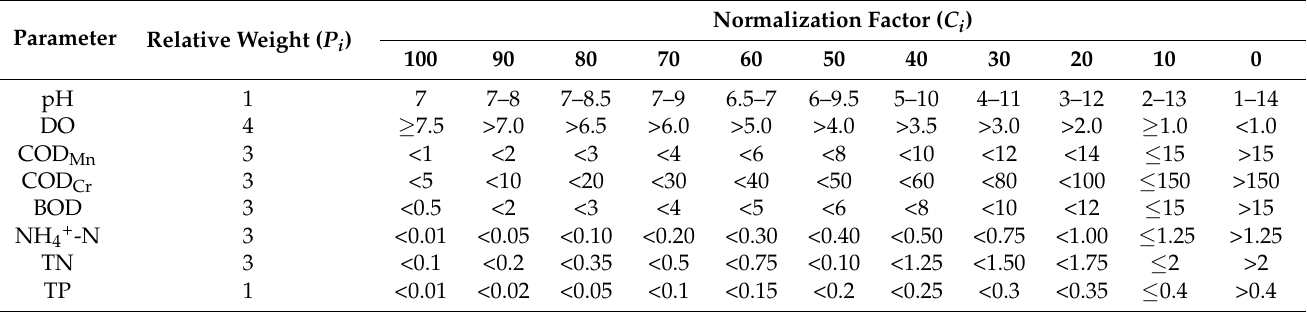
Table 1. Score and weight of water quality parameters for the WQI